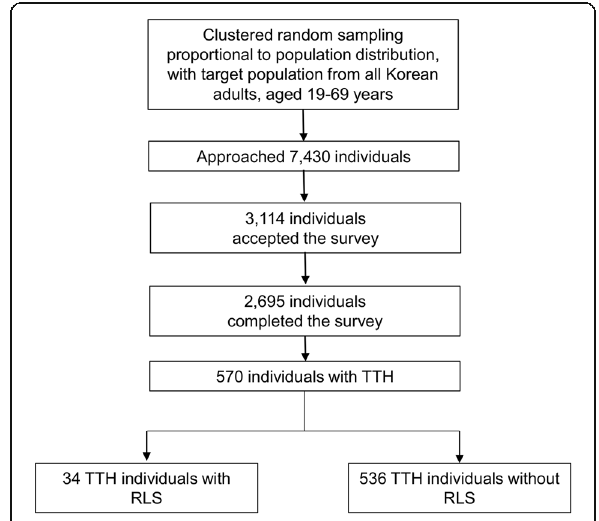
Fig. 1 Flowchart depicting the participation of subjects in the Korean Headache-Sleep Study. RLS, restless legs syndrome; TTH, tension-type